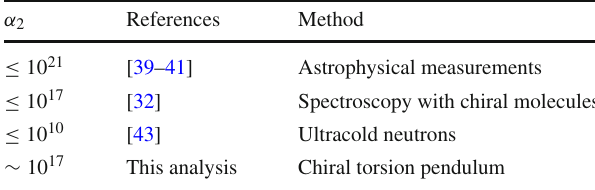
Table 1 Experimental bounds for the α 2 parameter. See text for details α